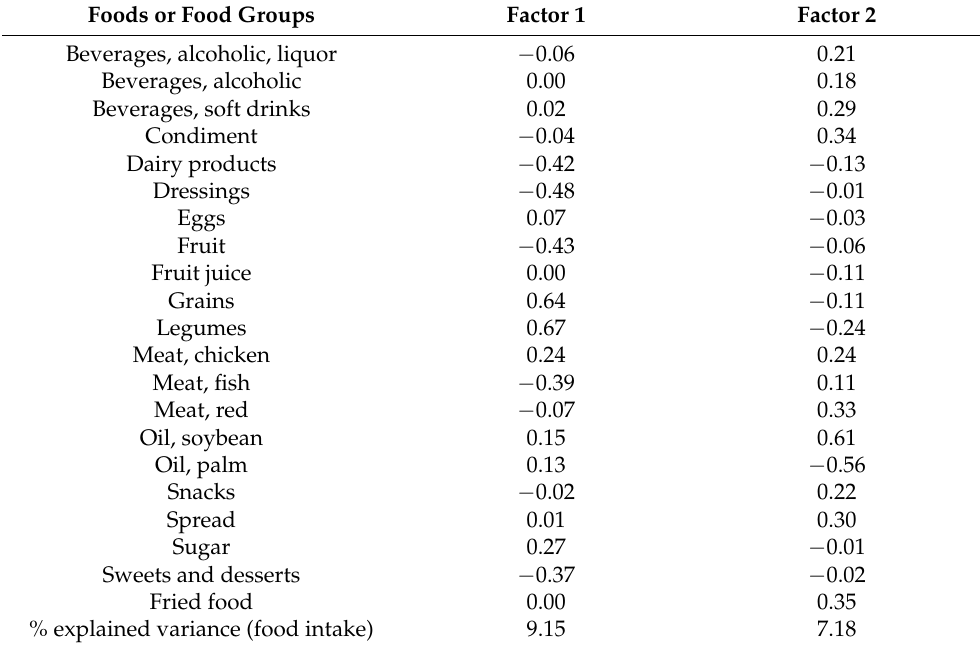
Table 1. Factor loadings of food groups with the two major dietary